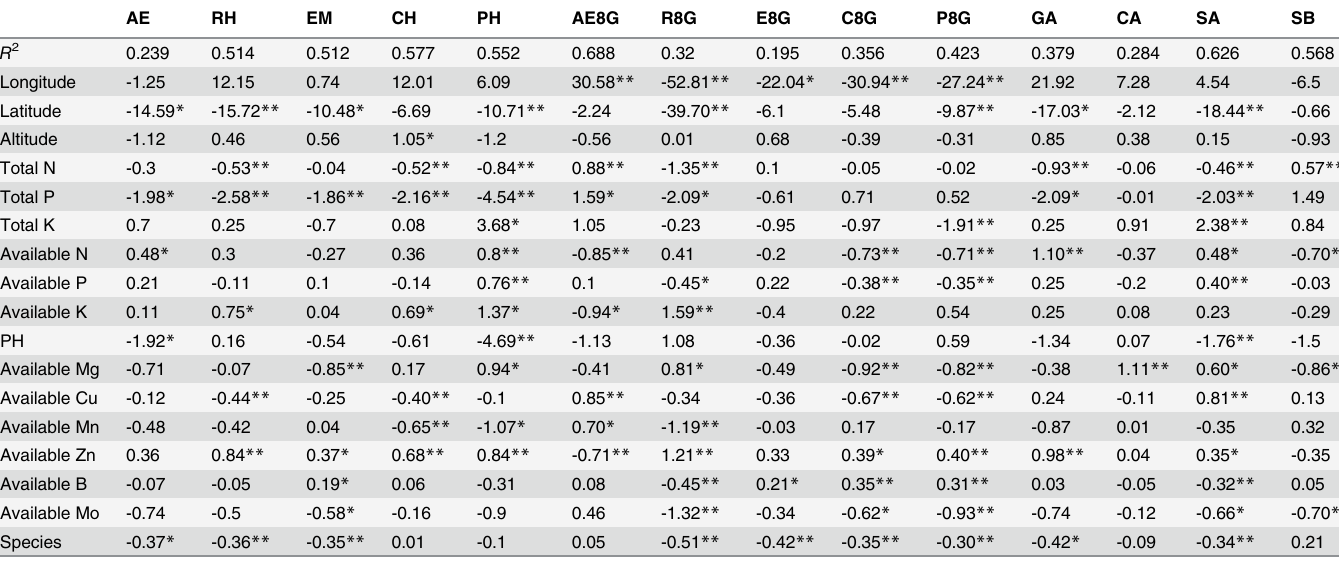
Table 1. Regression analysis results for the influencing factors and 14 API in